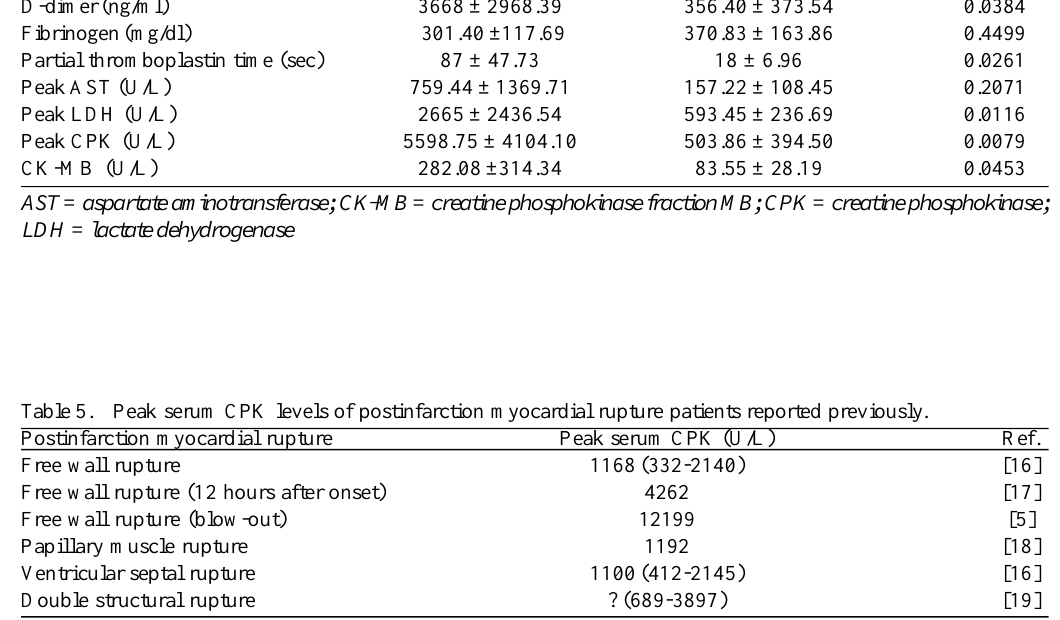
Table 4. A comparison of the the hemostatic markers and serum enzymes between non-survivors and survivors.